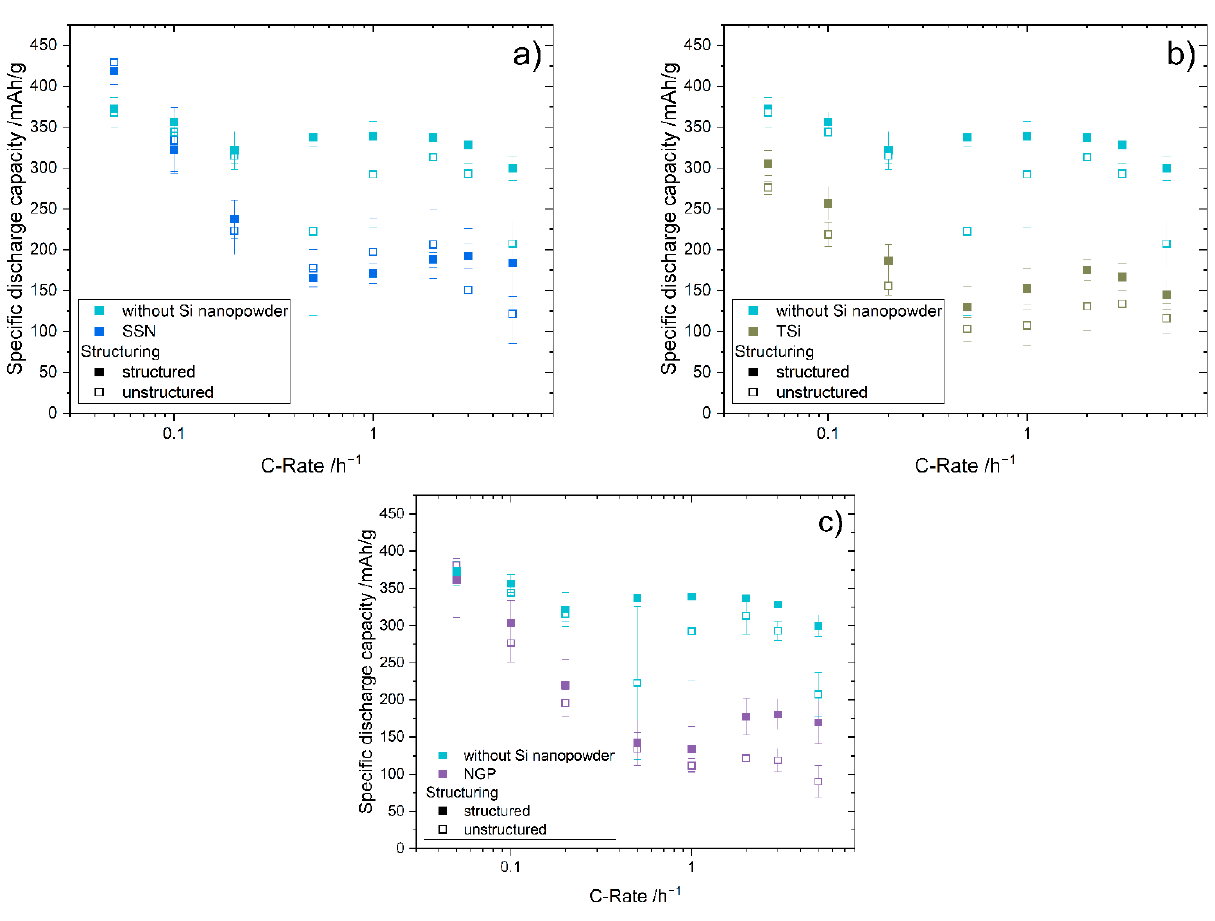
Figure 6. Mean specific discharge capacity of the half-cells depending on the C-rate of the structured and unstructured graphite electrodes without silicon and ( a ) electrodes with SSN SiNP, ( b ) electrodes with TSi SiNP, and ( c ) electrodes with NGP SiNP.